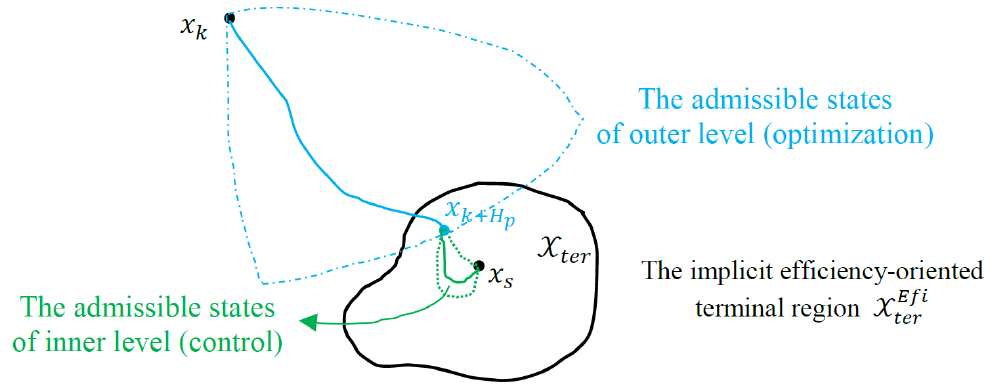
Figure 3. Illustration of practical efficiency-oriented